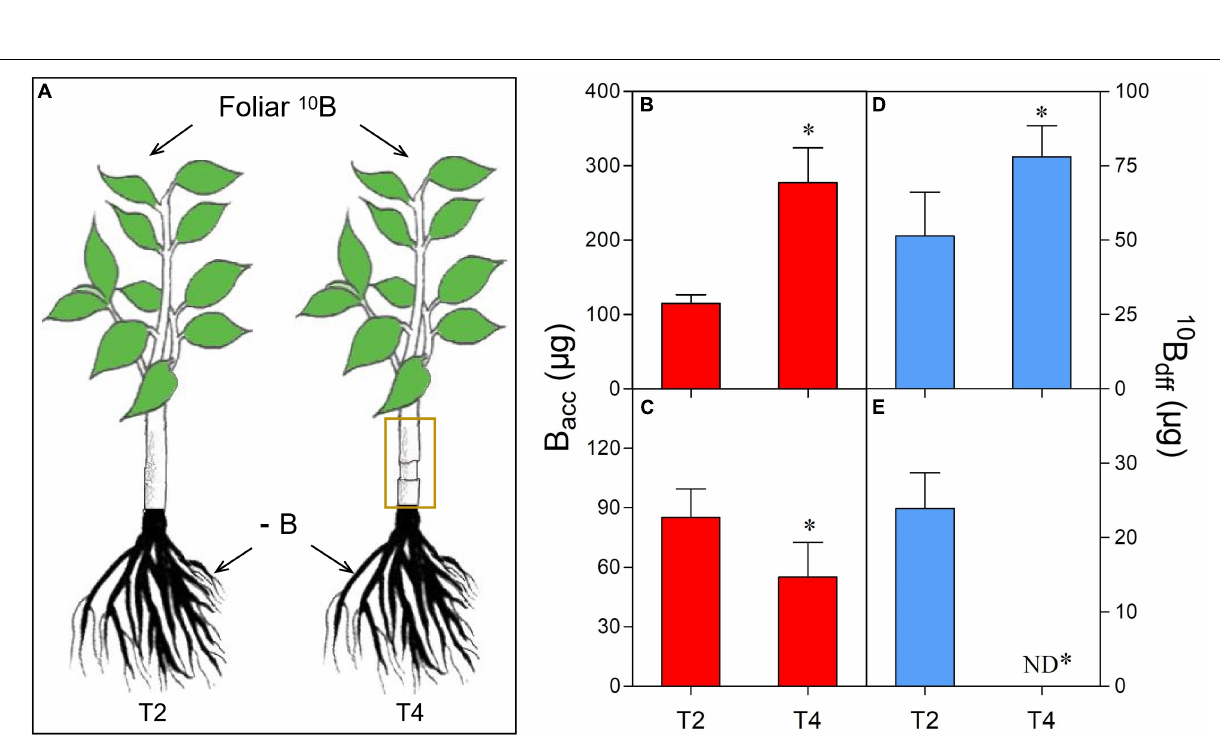
FIGURE 2 | Comparison of B accumulation (B acc ) and 10 B concentration derived from foliar 10 B ( 10 B dff ) in leaves (B,D) and roots (C,E) of different treatments (A) . The yellow box refers to girdling the stem of foliar- 10 B treated plants as treatment 4 (T4). “ ∗ ” in each graph indicates significant differences between T2 and T4 treatments ( t -test, n = 4, P <